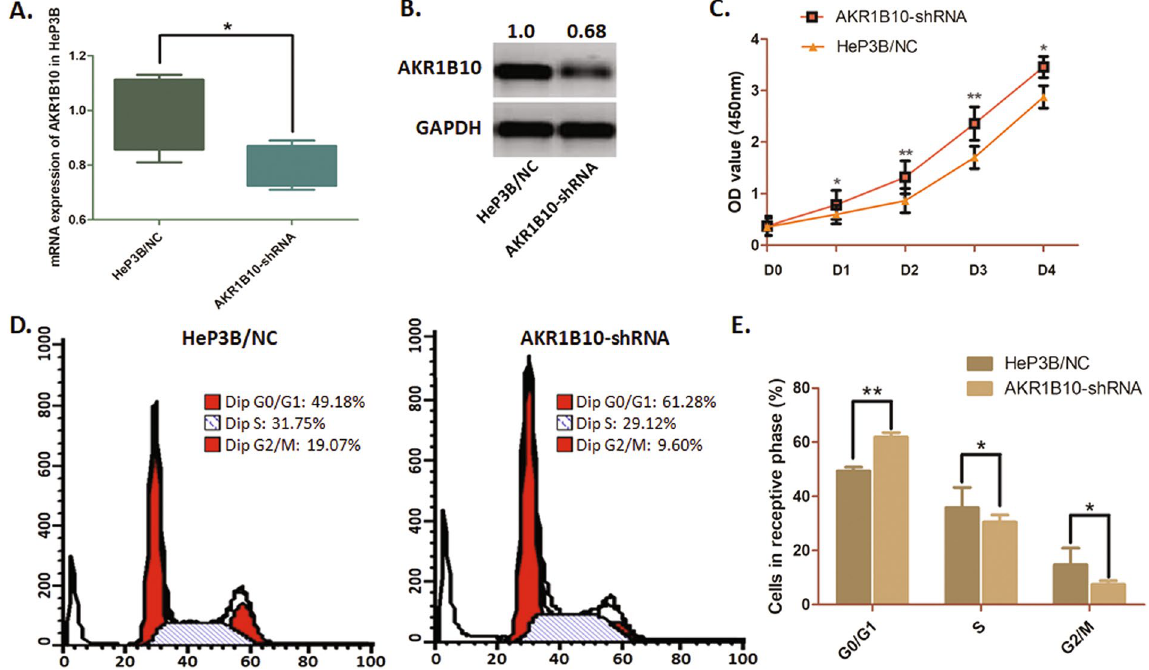
Figure 5. Knock-down AKR1B10 in HeP3B cells impairs cell proliferation and arrests cell cycle. ( A ) QRT-PCR assay verified the significant expression decline of AKR1B10 at mRNA status in HeP3B cells through shRNA transfection by using pGU6/Neo vectors ( * P < 0.05). ( B ) Western-blot analysis indicated a significant decrease of AKR1B10 at protein status in HeP3B cells through shRNA transfection by using pGU6/Neo vectors. The blot was cropped and matched according to the columns from the same gel. ( C ) The effect of AKR1B10 on cell proliferation was determined by WST assay. The cell proliferation of HeP3B cells was significantly suppressed when AKR1B10 knocked down ( * P < 0.05 for d1 and d4; ** P < 0.01 for d2 and d3). ( D ) Representative histograms describing cell cycle profiles of HeP3B cells. The cell cycle was significantly arrested in G0/G1 phase when AKR1B10 knocked down. ( E ) Proportion of cells in various phases of the cell cycle. The results are means of three independent experiments_SD ( ** P < 0.01, * P <